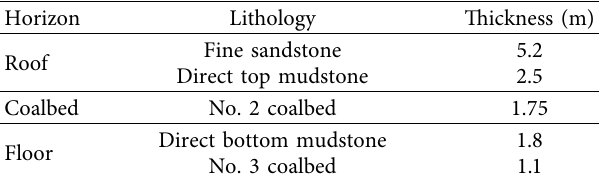
Table 1: Lithological characteristics of No.2 coal